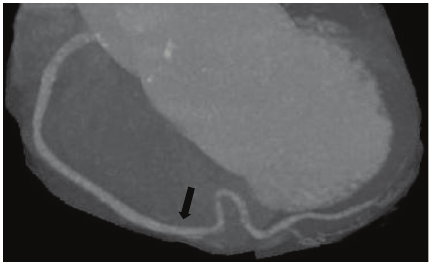
Figure 3: A maximal intensity projection image shows overall course of superdominant right coronary artery